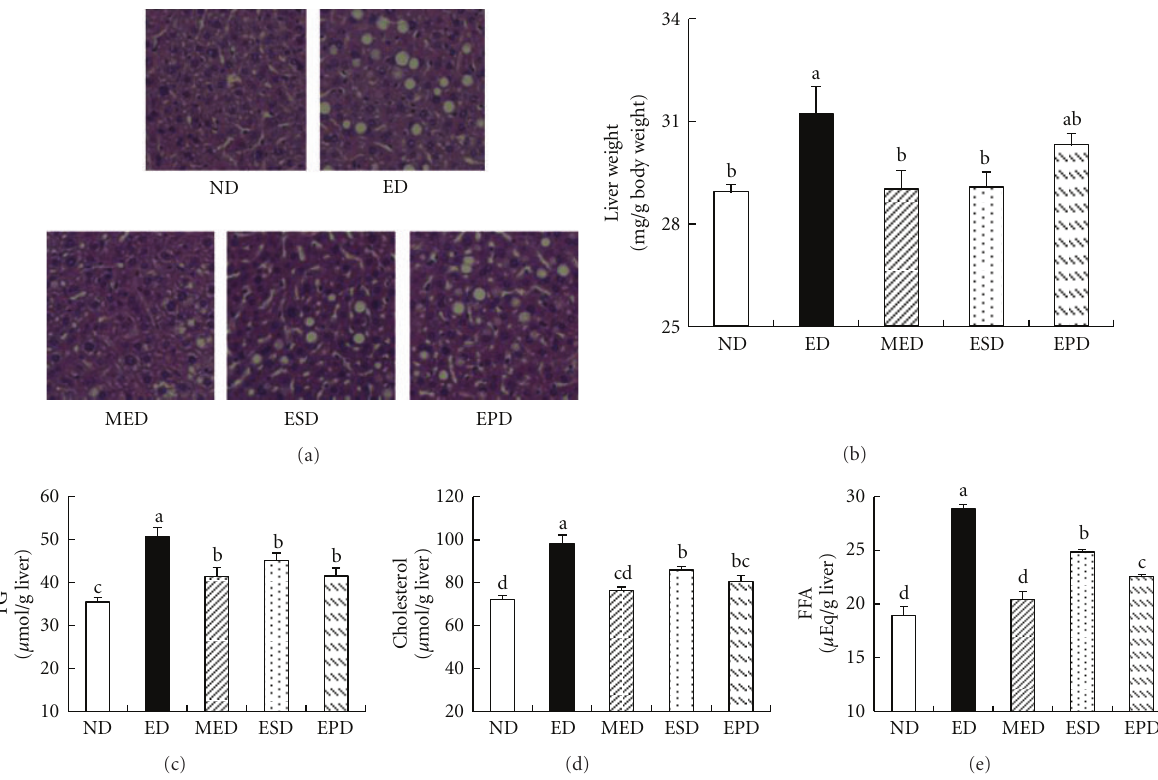
Figure 1: Codonopsis lanceolata extracts substantially reduces alcohol-induced liver steatosis. (a) Hematoxylin and eosin-stained sections of representative liver samples of the treated groups (100 × ). (b) Changes in the liver-to-body weight ratio. Hepatic triglyceride, free fatty acid, and cholesterol levels are shown in (c, d, and e). The data are expressed as means ± SEM ( n = 8). a,b,c,d Means not sharing a common letter are significantly di ff erent ( P < 0 .